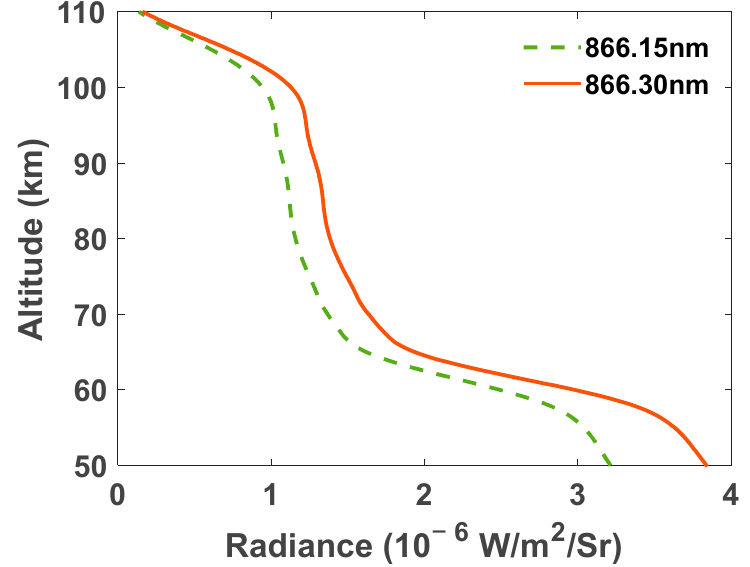
Figure 4. LOS integral radiance of two emission lines.